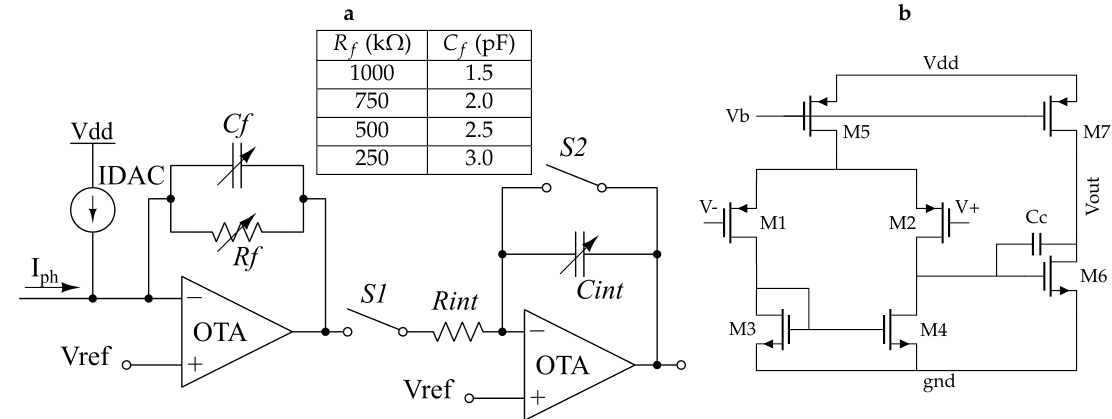
Figure 3. ( a ) Schematic of the PPG analog front end. The inset shows the programmable options for choosing among the built-in R f - C f value pairs. ( b ) Transistor-level schematic of the OTAs used in the AFE.